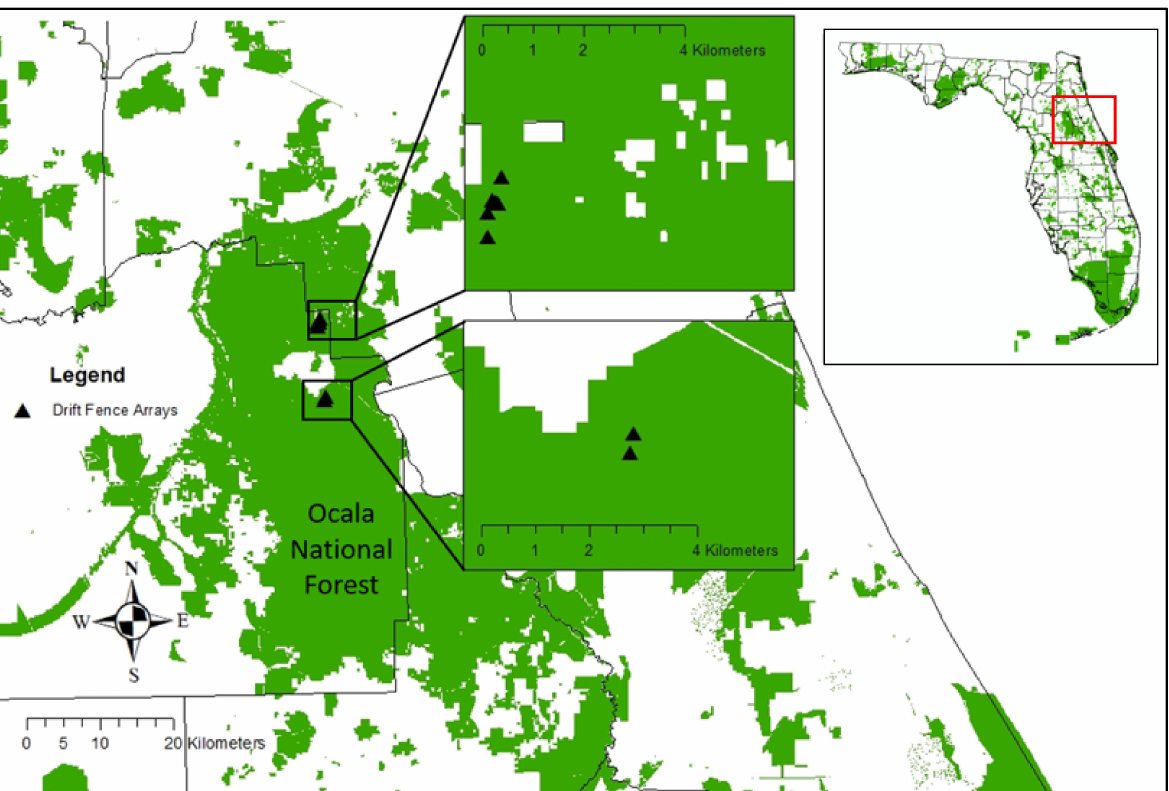
Figure 2. Location of study sites, Ocala National Forest, Marion County, Florida. Figure taken from Button et al., 2017